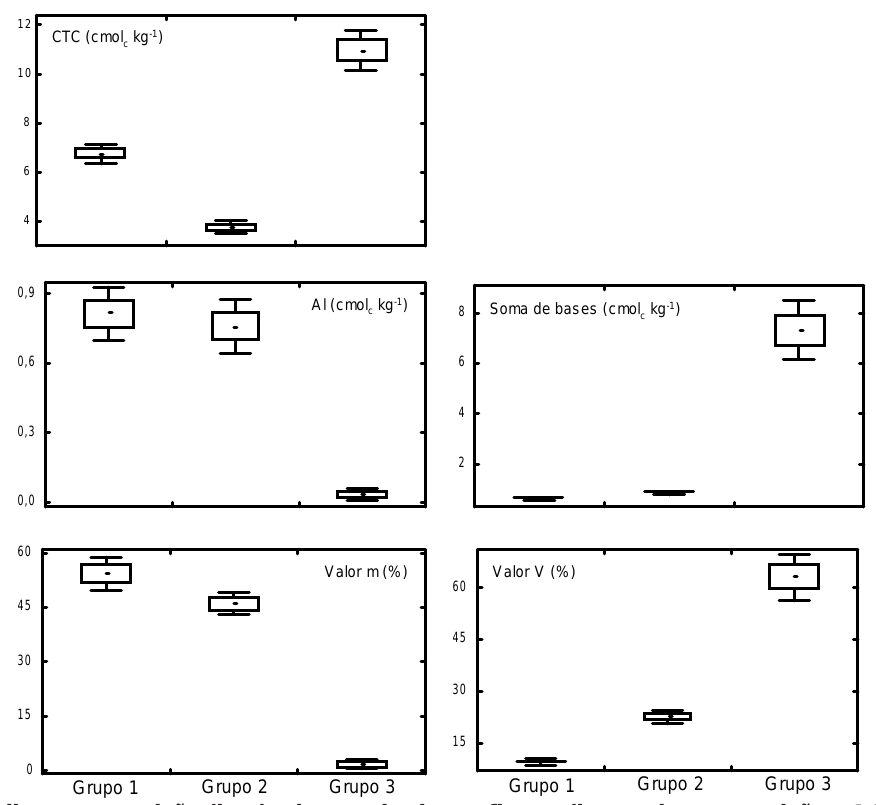
Figura 5. Médias, erro-padrão (box) e intervalo de confiança (barra de erro-padrão ××××× 1,96) de variáveis relacionadas com a oferta de nutrientes para as amostras de horizontes superficiais dos grupos de perfis de solo: 1 = solos de textura argilosa a muito argilosa, hipo a mesoférricos; 2 = solos de textura média a arenosa, hipoférricos; 3 = solos de textura argilosa a muito argilosa, férricos.